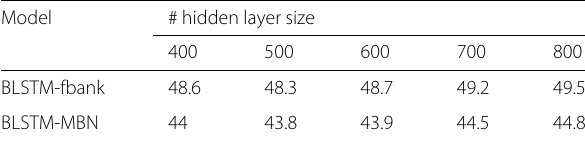
Table 5 BLSTM accuracy as a function of the hidden layer size Model